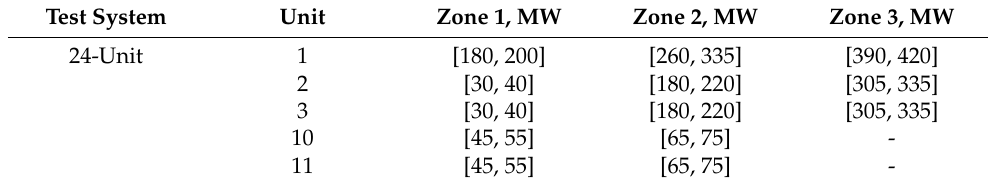
Table A3. Prohibited operating zones of the 24-unit test